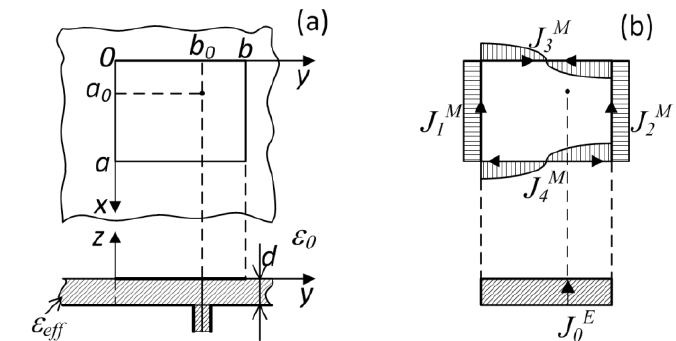
Fig.1. The structure of the investigted magnetoelectric antenna: (а) design; (b) current